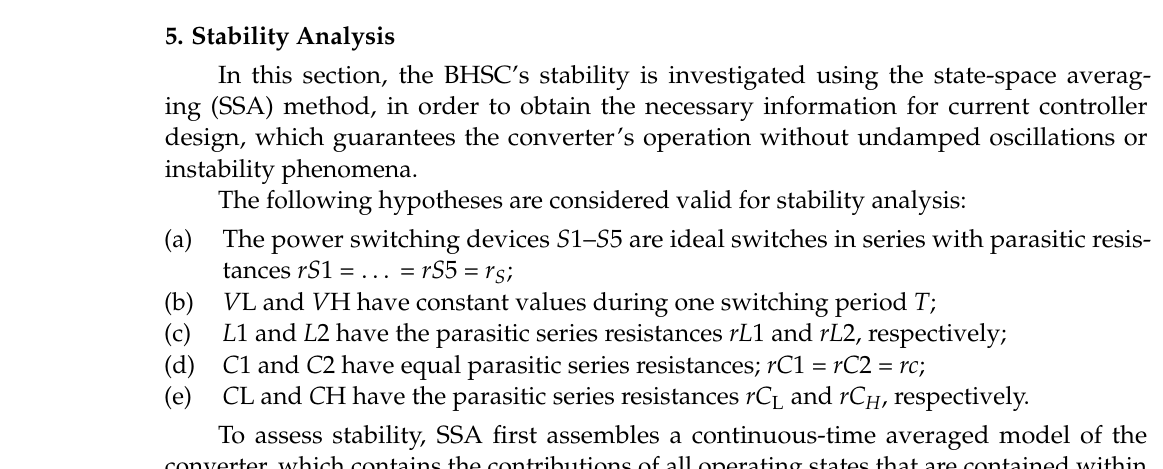
Figure 13. Radar chart with 5 axes: voltage conversion ratio (@D = 15%); number of components; total active switch stress; mean inductor energy; mean capacitor energy. ( a ) Chart of converter 7. ( b ) Chart of converter 8.